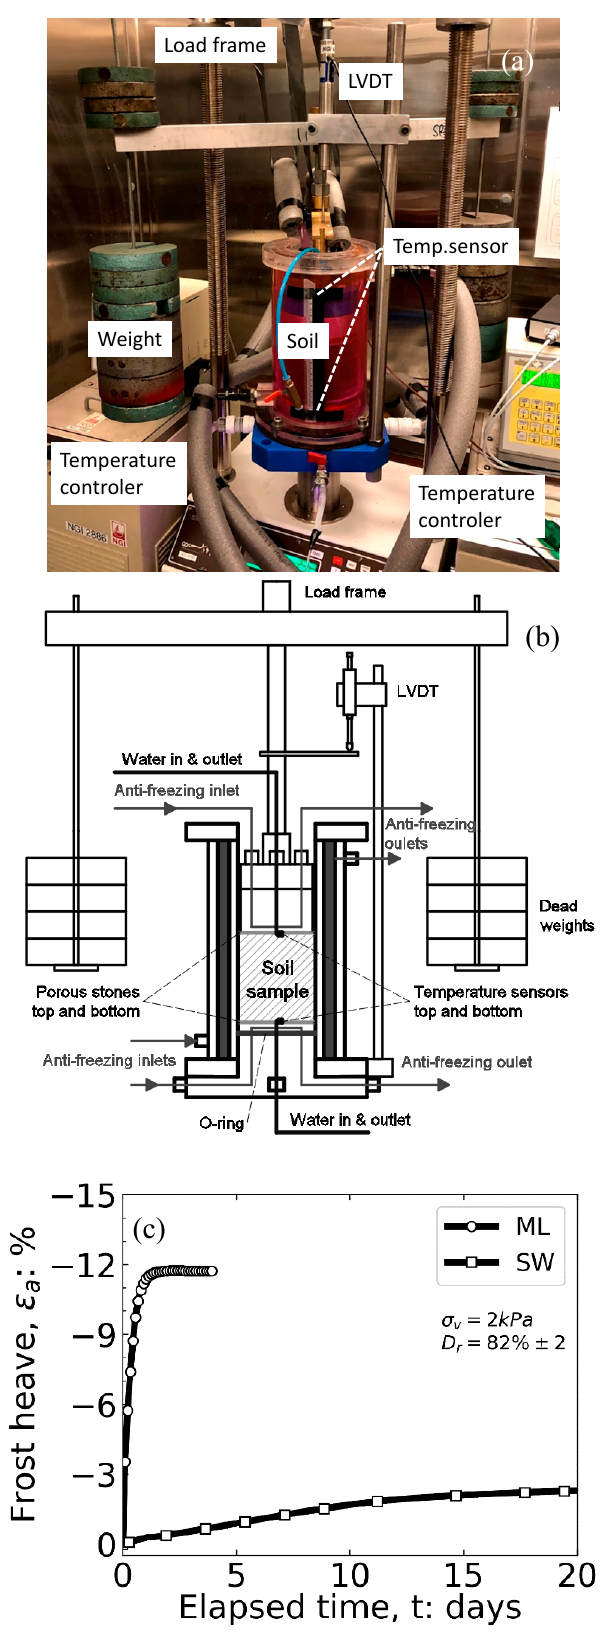
Figure 6. ( a ) Soil heave test apparatus with temperature controller (NGI and KICT); ( b ) Sketch of temperature-controllable cell (modified from Jin et al.) [17]; ( c ) Frost heave results on ML and SW soils.